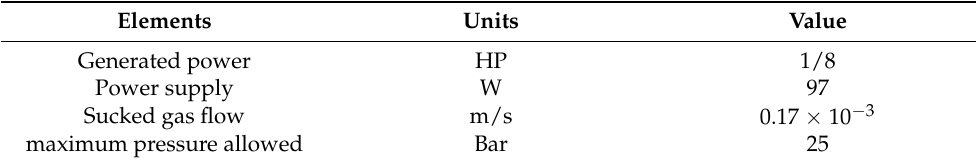
Table 6. Characteristics of the chosen compressor.